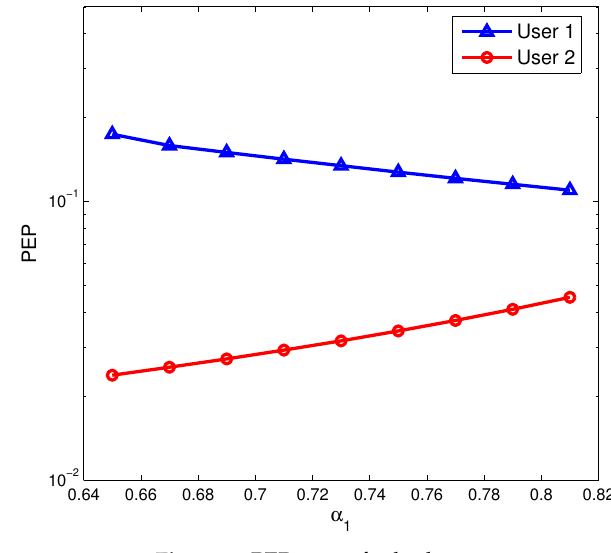
Figure 5. PEP vs. α 1 for both users.